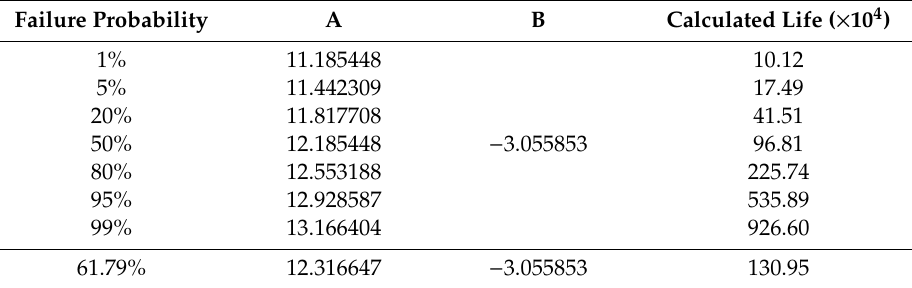
Table 1. Fatigue life calculated by ESS method with di ff erent failure